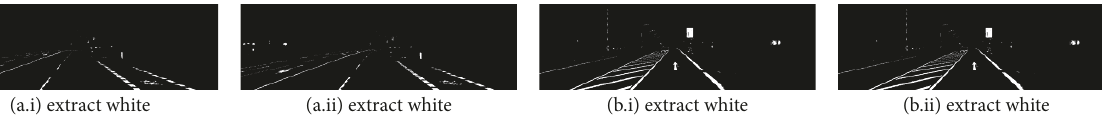
Figure 16: White extraction of frames (a) and (b).